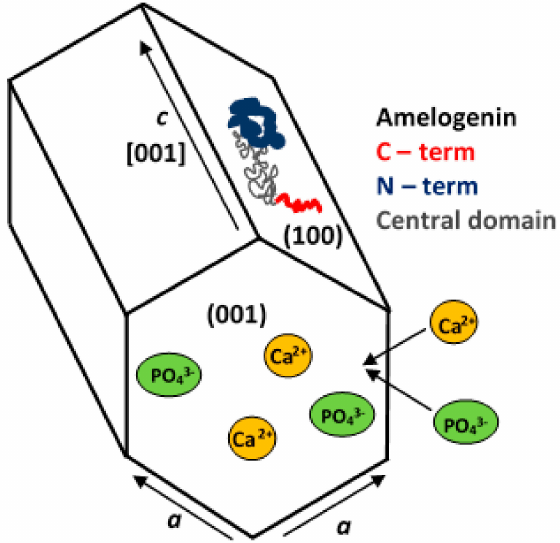
Figure 6. Model of the amelogenin (AMEL)-controlled growth of hydroxyapatite (HA)